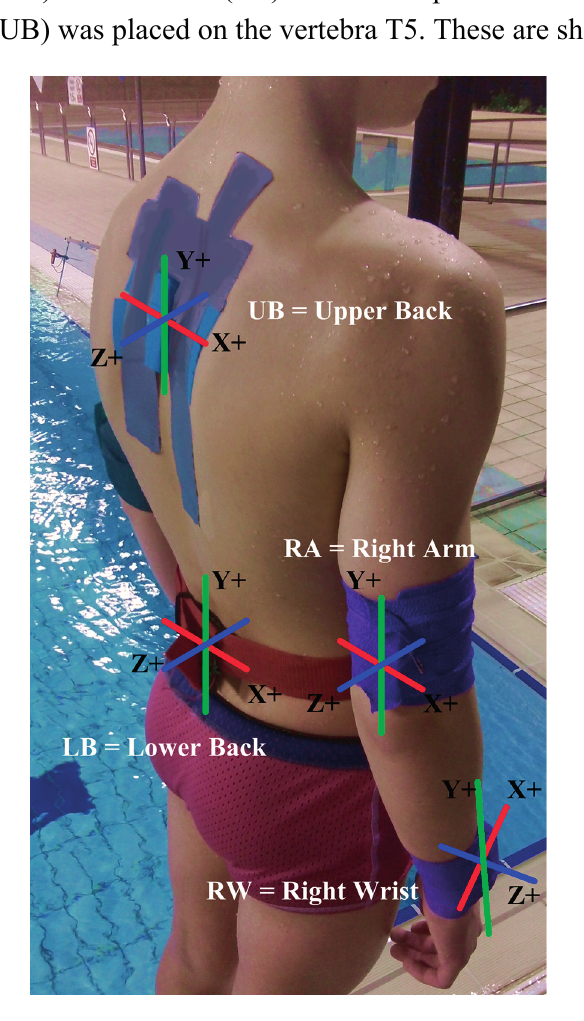
Figure 3. Device placement and attachment method and